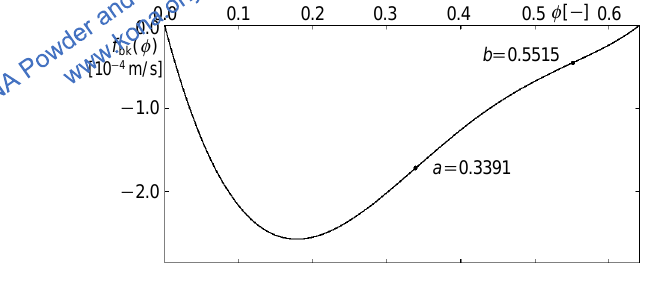
Fig. 4 Flux density function for glass beads with two inflection points a and b , after Shannon et